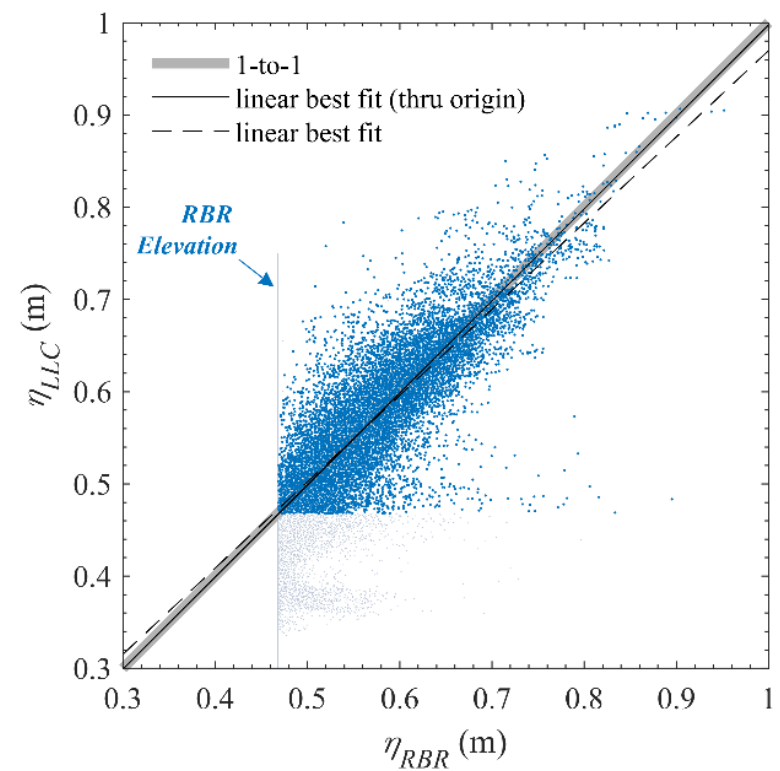
Figure 14. RBR- versus LLC LiDAR-derived free-surface elevations for nine 25-minute segments during Series C (high tide #3). Dot colors follow Figure 12 legend. Linear best fits were performed via least-square-error regression.